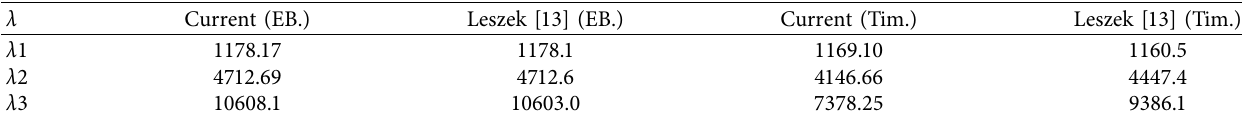
Table 5: First 3 natural frequencies for beam (1).